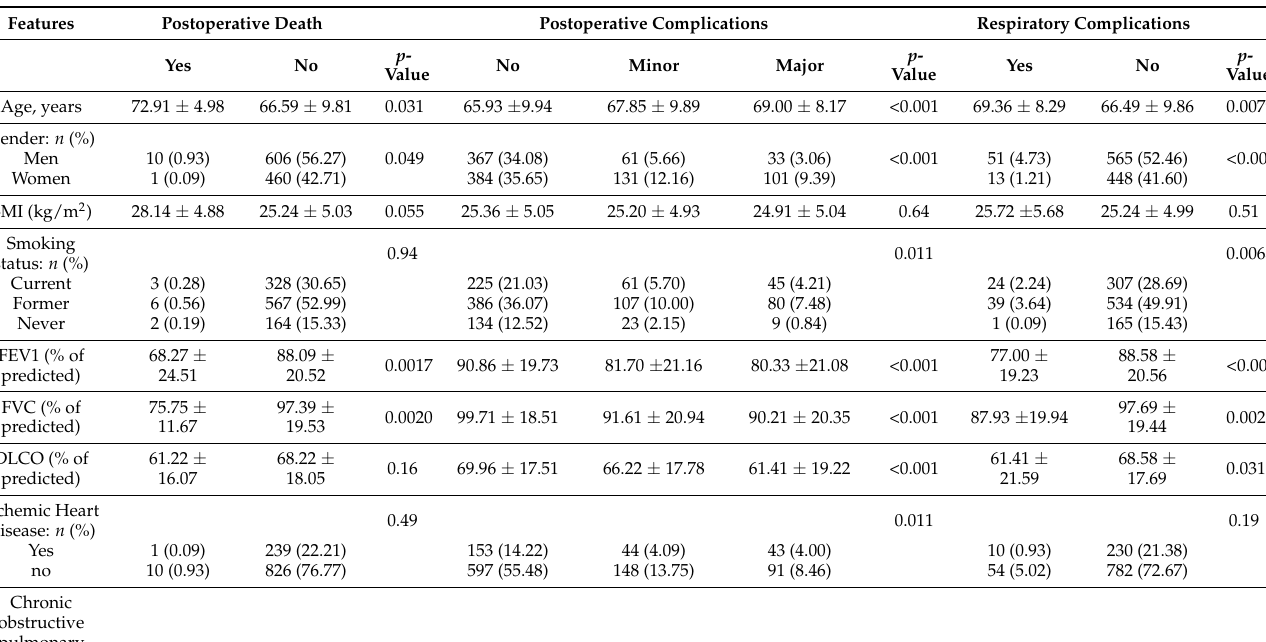
Table 6. Impact of clinical and pathological variables on survival, follow-up and respiratory compli- cations. ASA: American Society of Anesthesiologists classification of physical status. COPD: Chronic Obstructive Pulmonary Disease. Mean ± 95% CI: 95% Confidence